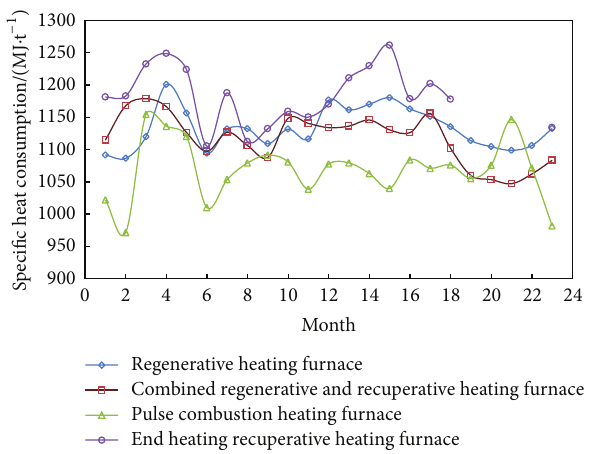
Figure 4: Comparison of specific heat consumption of four types of heating furnaces.